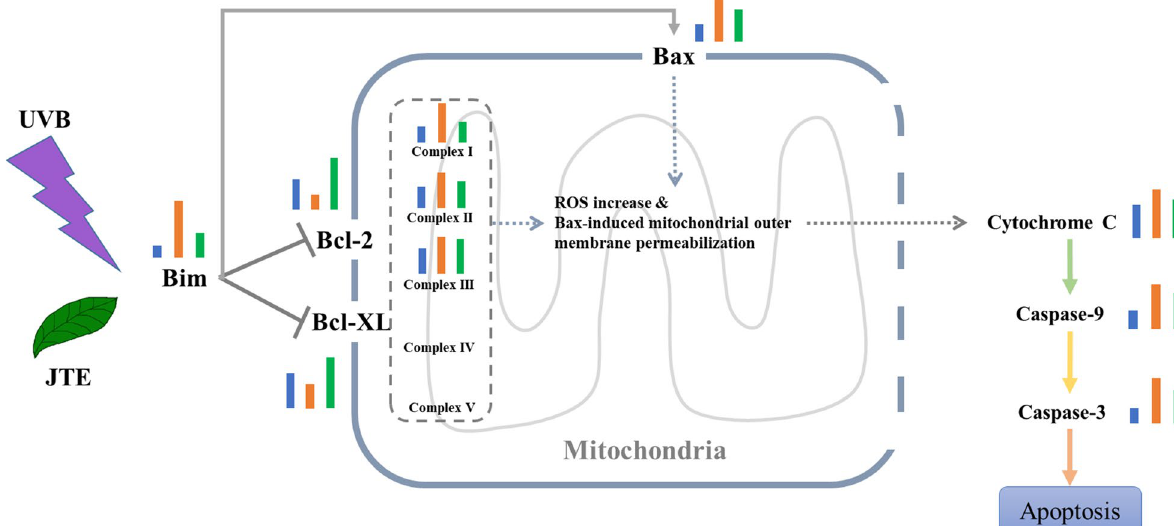
Fig. 8 The schematic of photoprotective mechanism of JTE. Redrawn from the KEGG Apoptosis Reference Pathway (https:// www. kegg. jp/ kegg- bin/ show_ pathw ay? map04 210). The bar plots represent the gene expression in normal control, UVB and UVB-JTE samples respectively from left to right. Bim: Bcl-2-like protein 11; Complex I: NADH-ubiquinone oxidoreductase; Complex II: succinate dehydrogenase; Complex III: ubiquinol-cytochrome c